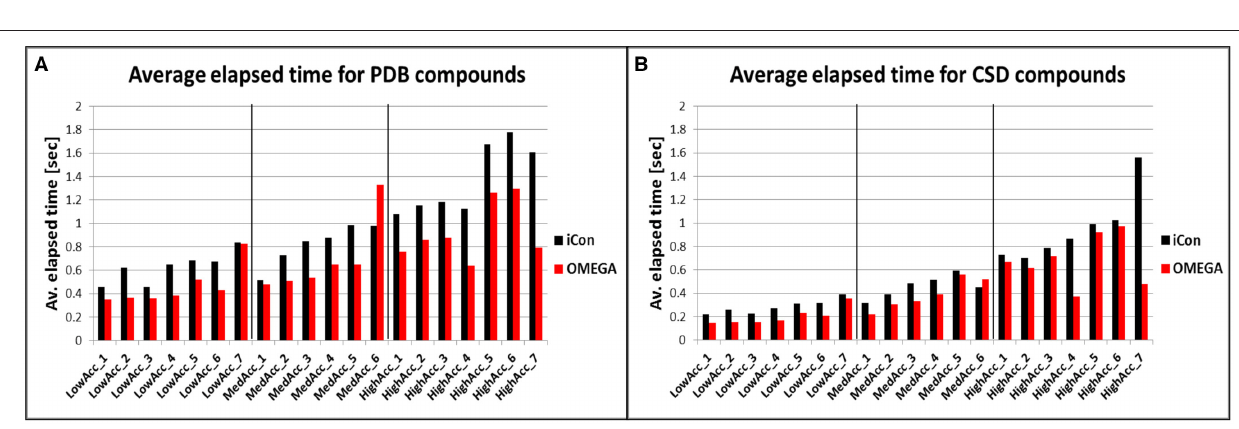
FIGURE 6 | Distributions of TC score values as a function of the number of rotatable bonds for CSD (A) and PDB compounds (B) . Distributions of RMSD values as a function of the number of rotatable bonds for CSD (C) and PDB compounds (D) .